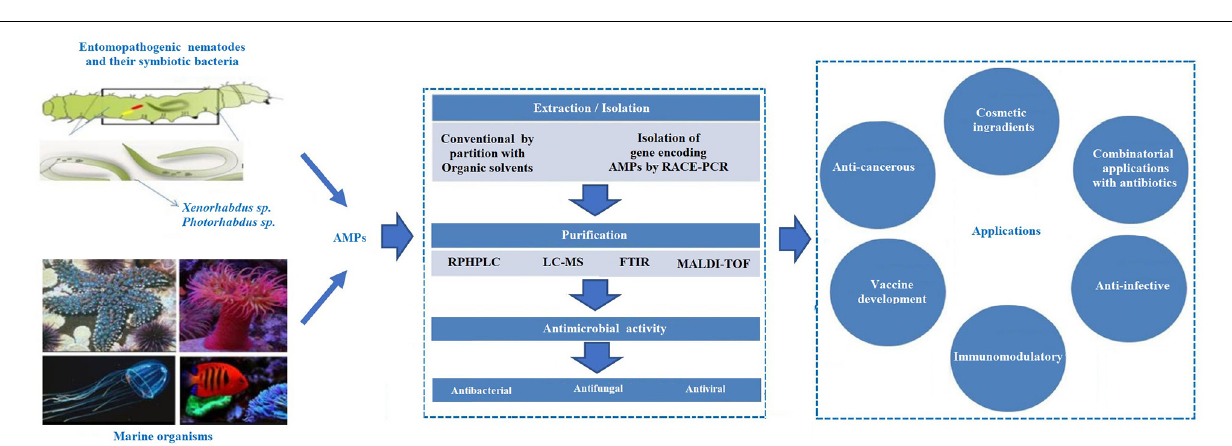
FIGURE 1 | Role of an antimicrobial peptide in immunomodulation, wound healing, and anticancer activity.